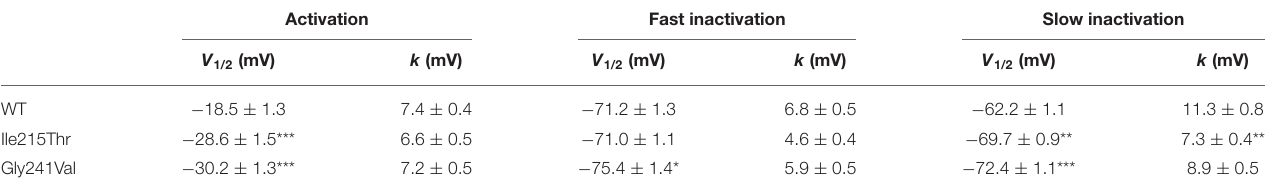
TABLE 3 | Voltage dependence of activation, fast inactivation, and slow